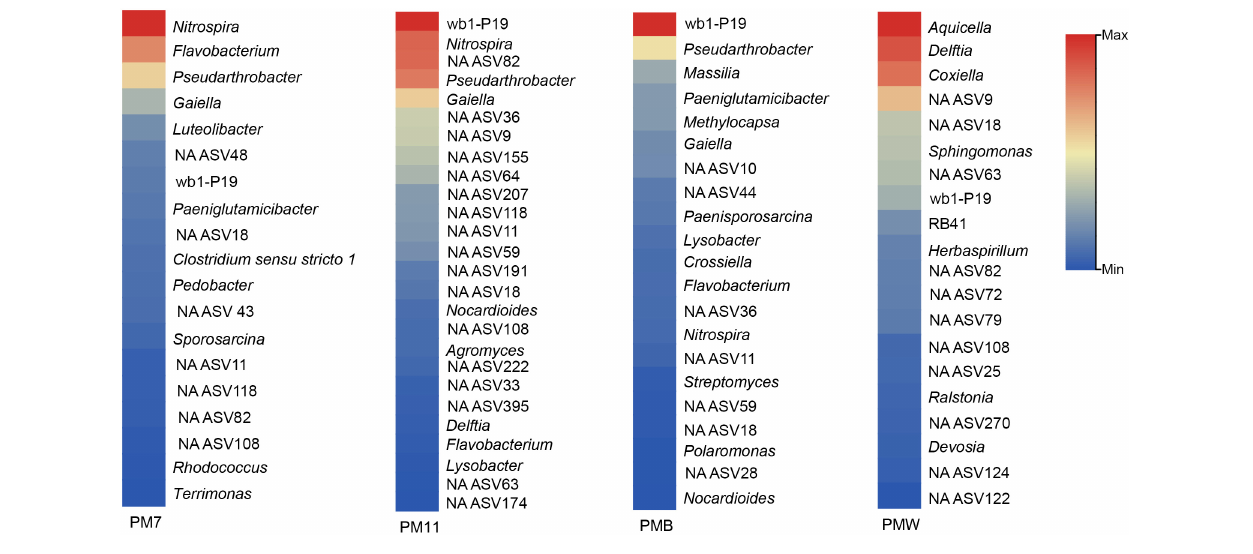
FIGURE 5 | The most abundant genera in each sample of Muierilor Cave ( > 1%).